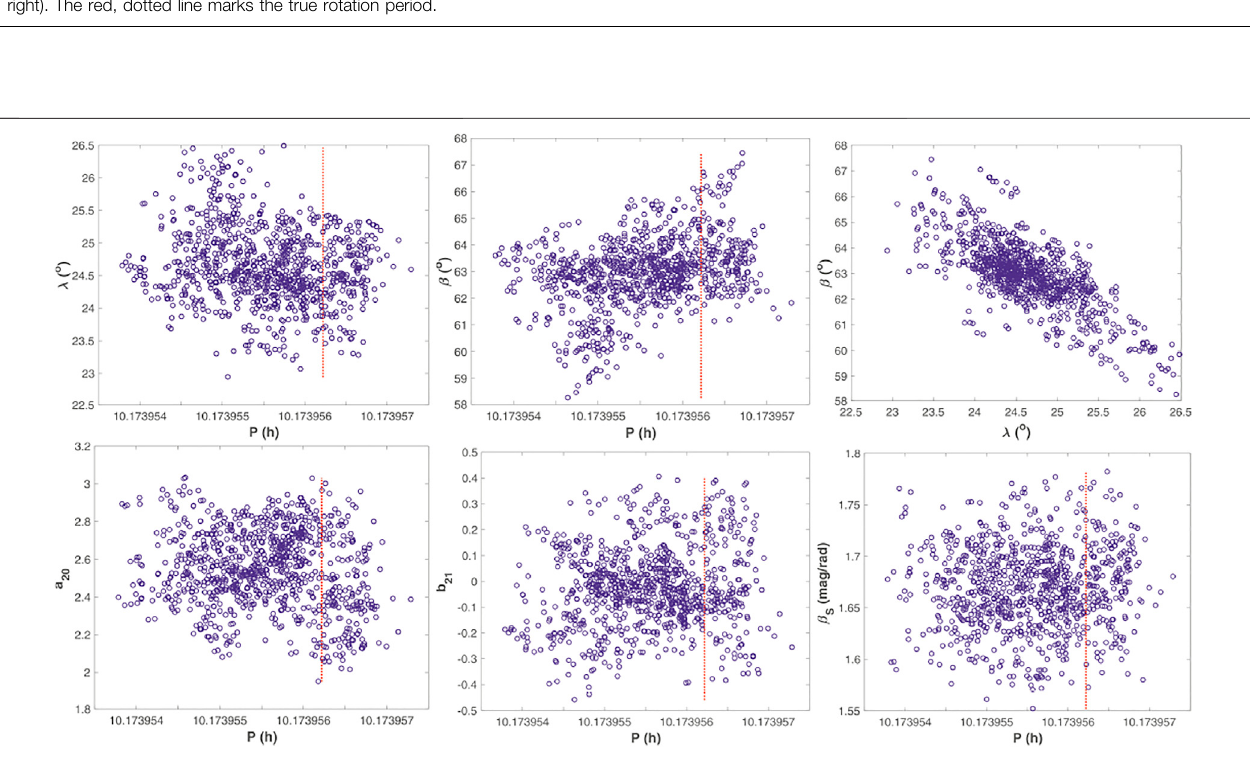
FIGURE 11 | As in Figure 10 in the case of absolute photometry.